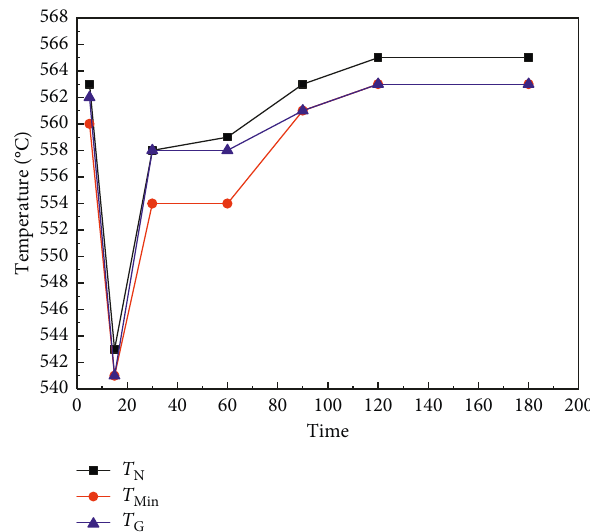
Figure 5: Characteristic temperature measured at different periods of time after combined additions of (Sr+Yb).